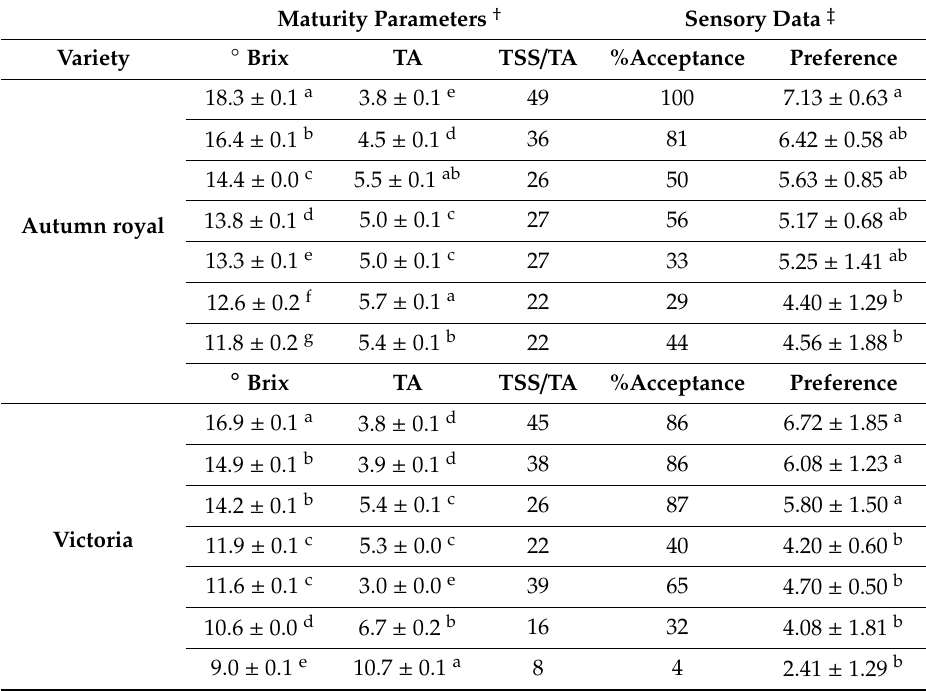
Table 2. Maturity parameters and consumers’